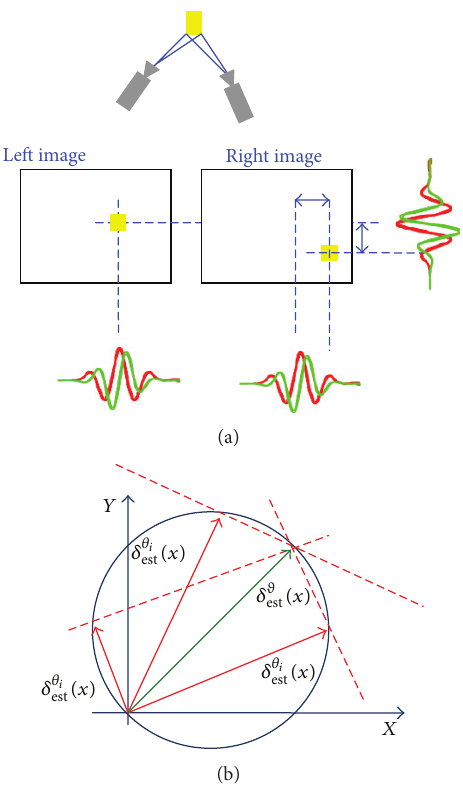
Figure 3: Graphical 2D disparity definition: the difference in the positions of the corresponding points in the stereo image pair (a); the longest vector whose end points lie on the cycle resulting in all the correct estimates 𝛿 est 𝜃 of the disparity component with respect to the orientation 𝜃 through the origin